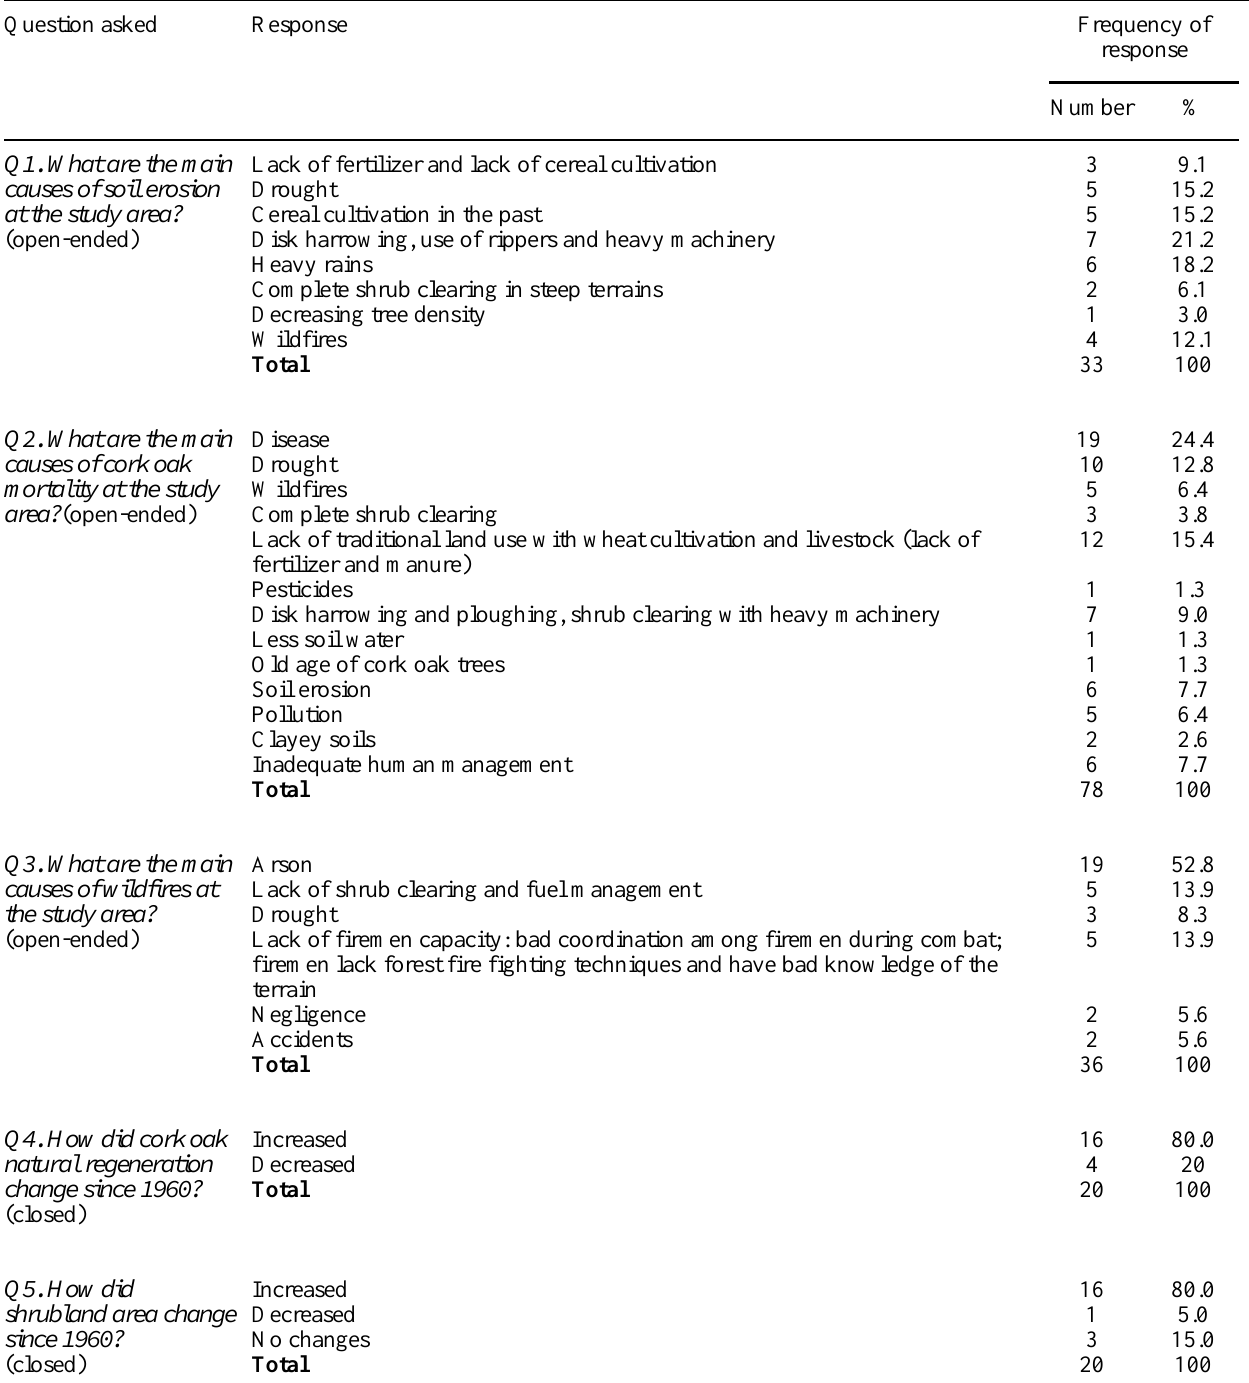
Table 3. Landowner’s individual perceptions (frequency of responses). Total number of responses per question (in Q1, Q2, and Q3) is higher than number of interviewees (20) because each interviewee usually provided more than one response to each